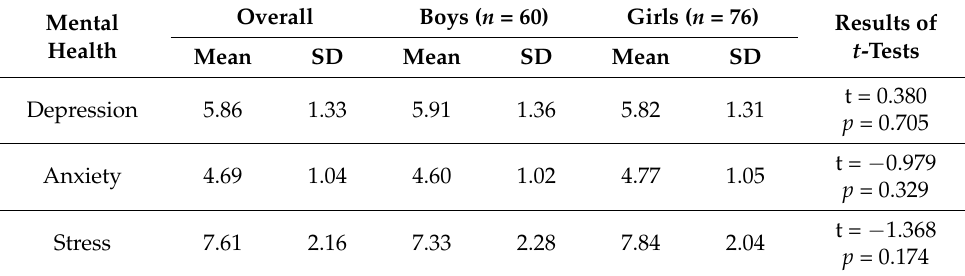
Table 3. Mental health data of the